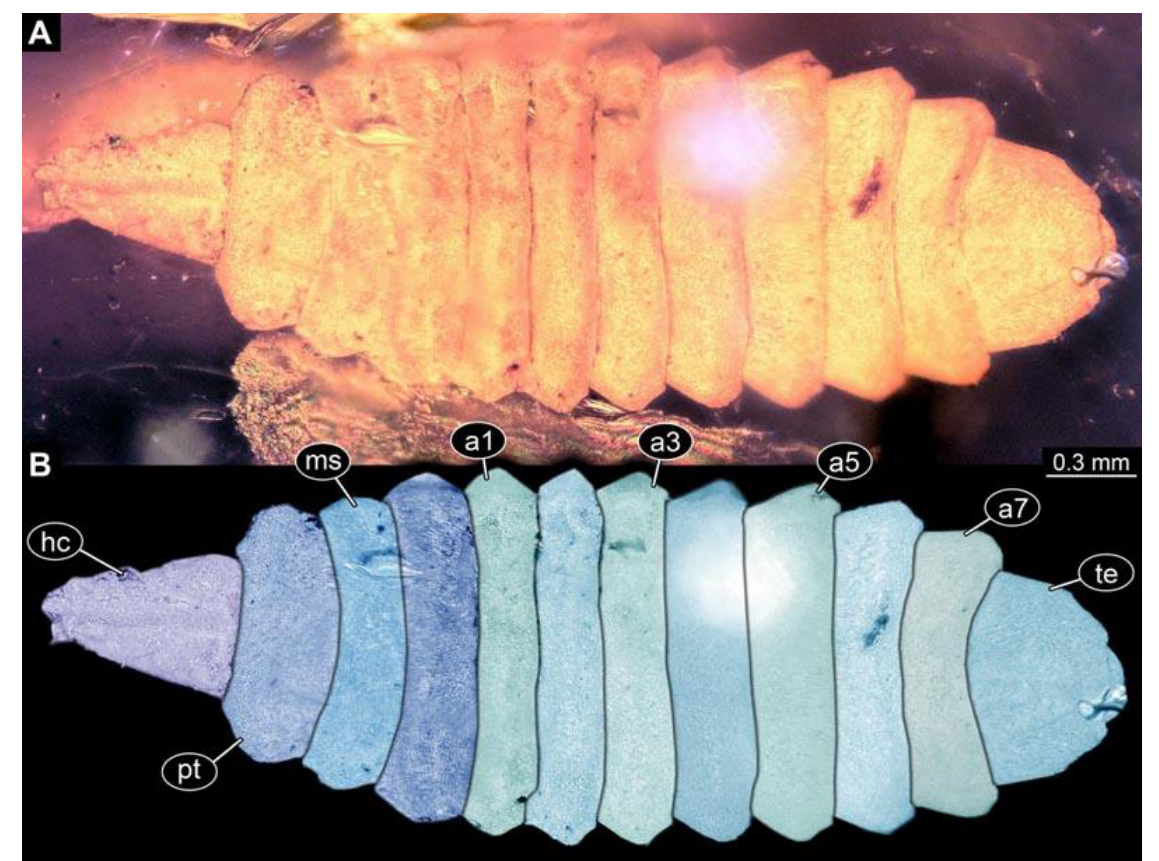
Figure 15. Fossil larva of morphotype 2, specimen PED 0821. ( A ). Full view of specimen. ( B ). Colour- marked. Abbreviations: a1 – a7 = abdomen units 1 – 7; hc = head capsule; ms = mesothorax; pt = prothorax; te = trunk end.